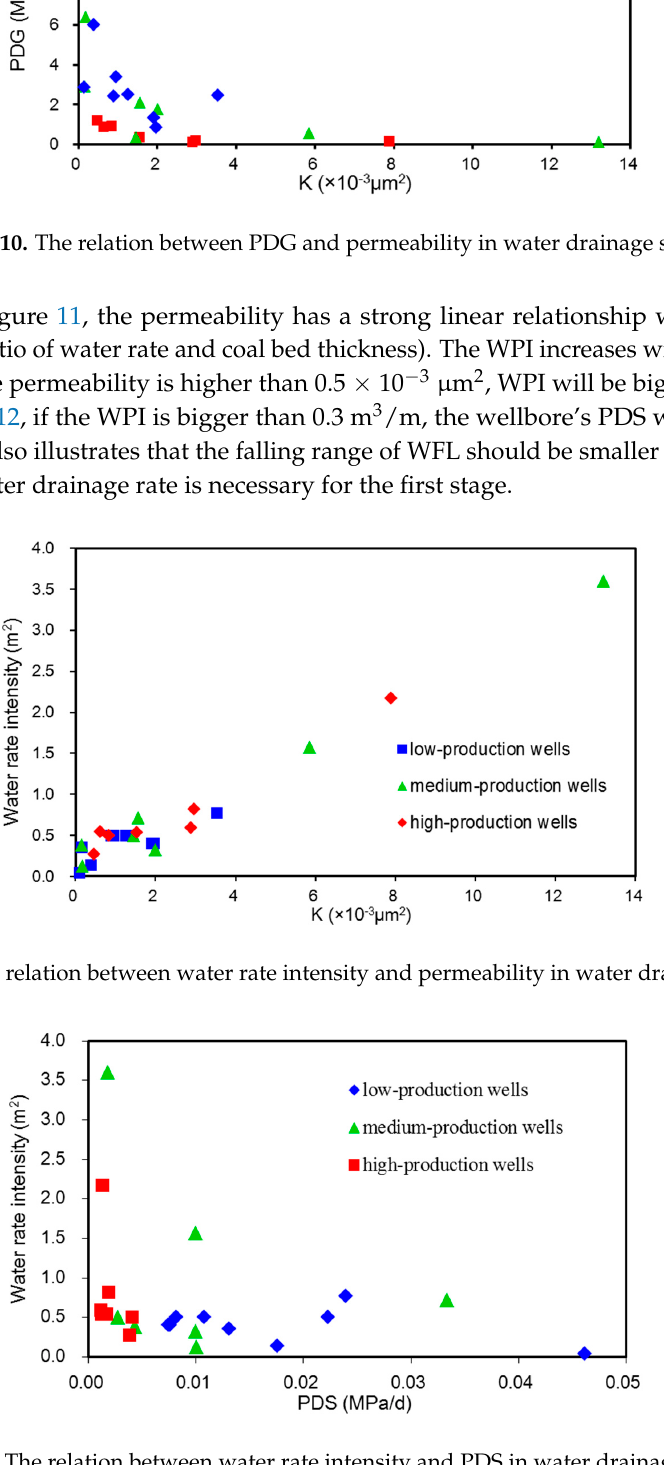
Figure 9. The relation between PDG and steady gas rate in water drainage stage.